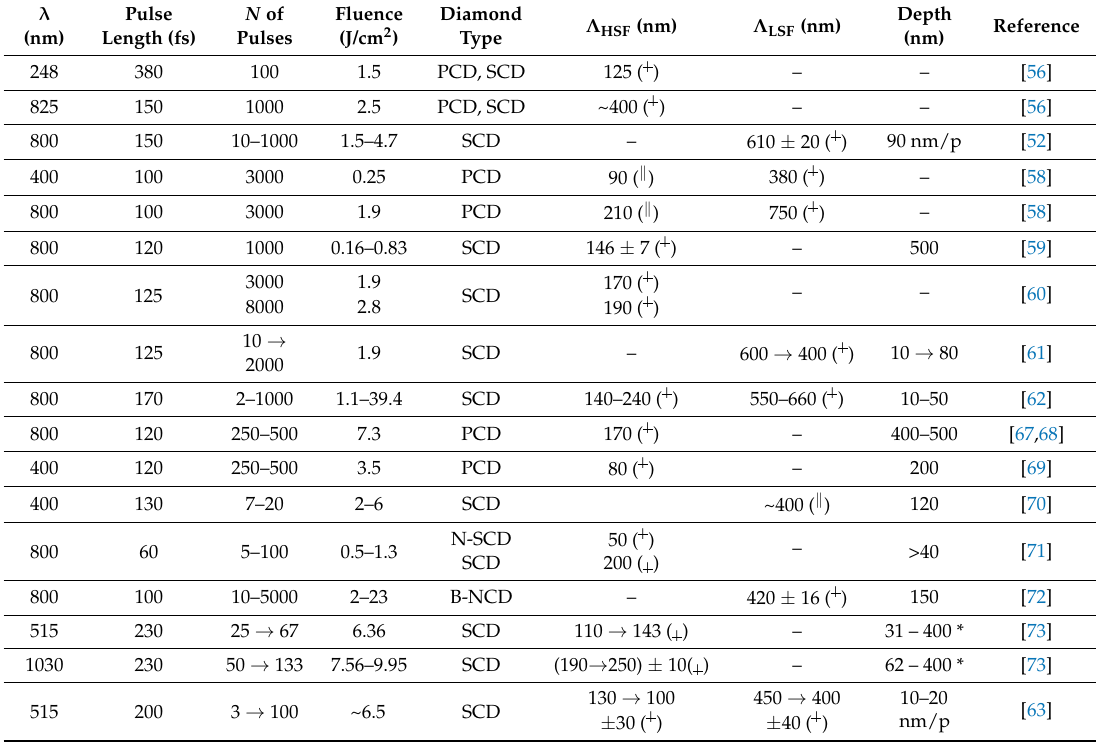
Table 1. Table resuming the ultrashort pulse laser parameters and the resulting features of the surface ripples, such as the periods Λ HSF and Λ LSF , for high and low spatial frequency, alignment and depth, together with the diamond type from the references investigated in this paper. All the reported experimental results have common parameters in linear laser polarization and conditions of perpendicularity between the laser optical path and the diamond